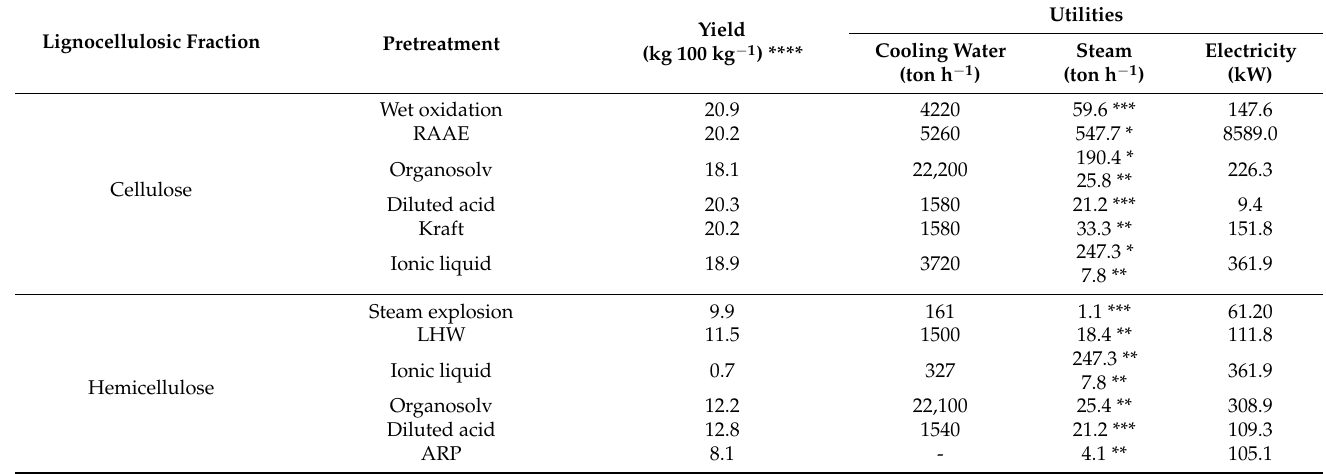
Table 4. Technical analysis of pretreatments to produce different lignocellulosic fractions.